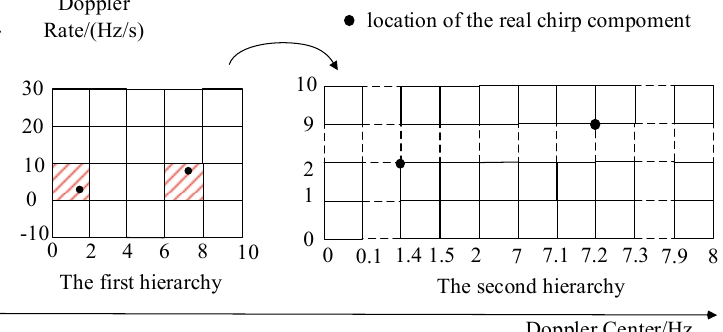
Figure 2. The illustration of the HBP strategy.